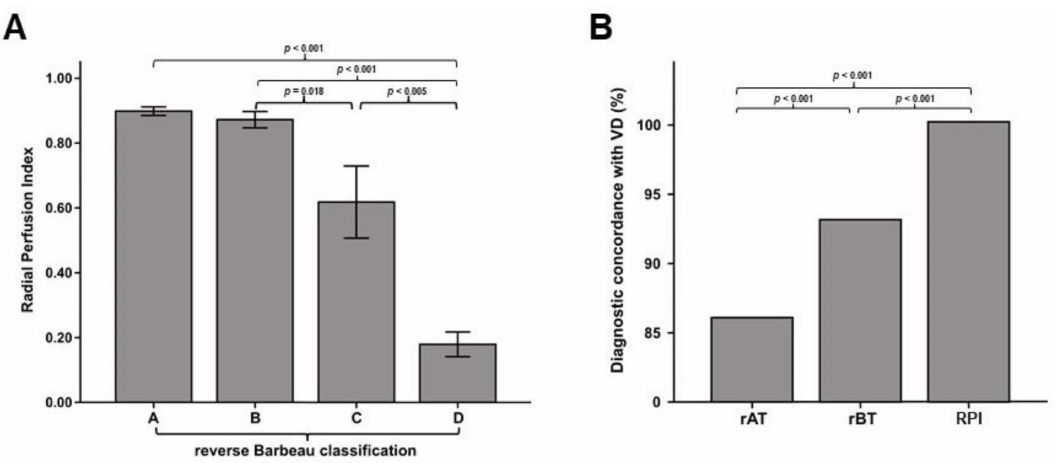
Figure 4. Quantitative value of the RPI. ( A ) The error bars depict mean RPI across different classes ot the reverse Barbeau Test (rBT). ( B ) The bar graph shows diagnostic concordance with the Vascular Duplex (VD), the standard of reference. Diagnostic concordance was significantly and progressively increased from the reverse Allen Test (rAT) (86%), through the rBT (93%) to the RPI